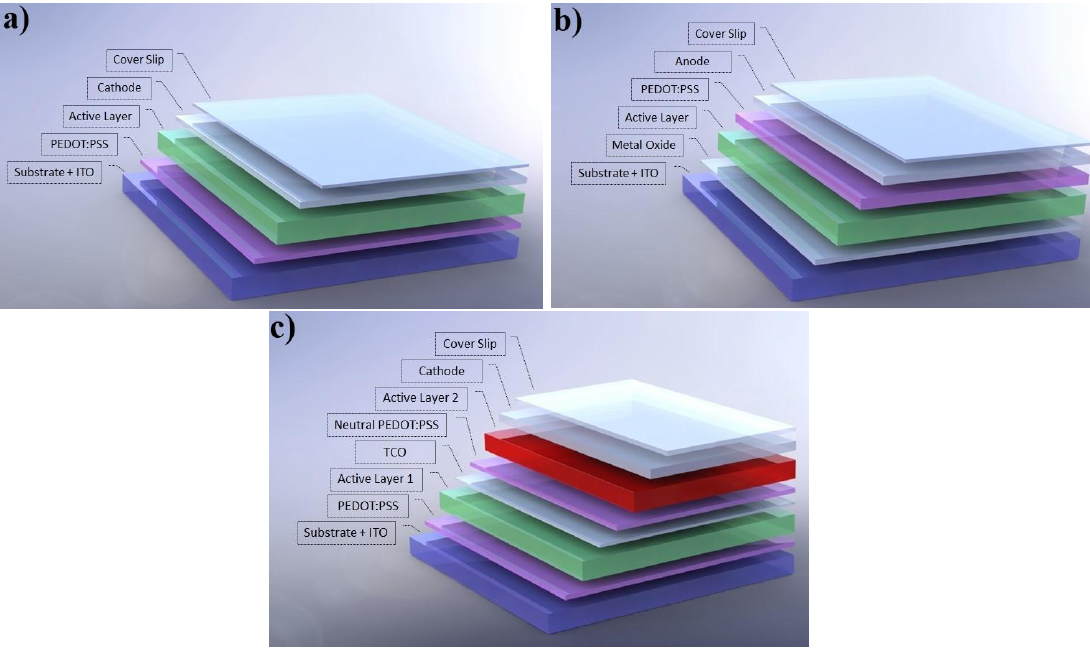
Figure 1. Architectures used in the construction of OPV devices: ( a ) Standard (Normal); ( b ) Inverted and ( c ) Tandem. TCO and ITO stand respectively for “Transparent Conductive Oxide” and “Indium Tin Oxide.”